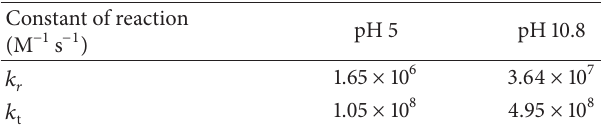
Table 2: Determined constant values (mean) of pH dependence of the